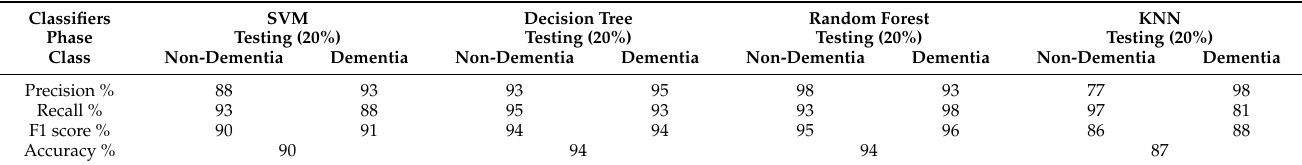
Table 8. Results of dementia diagnosis by using machine learning for each